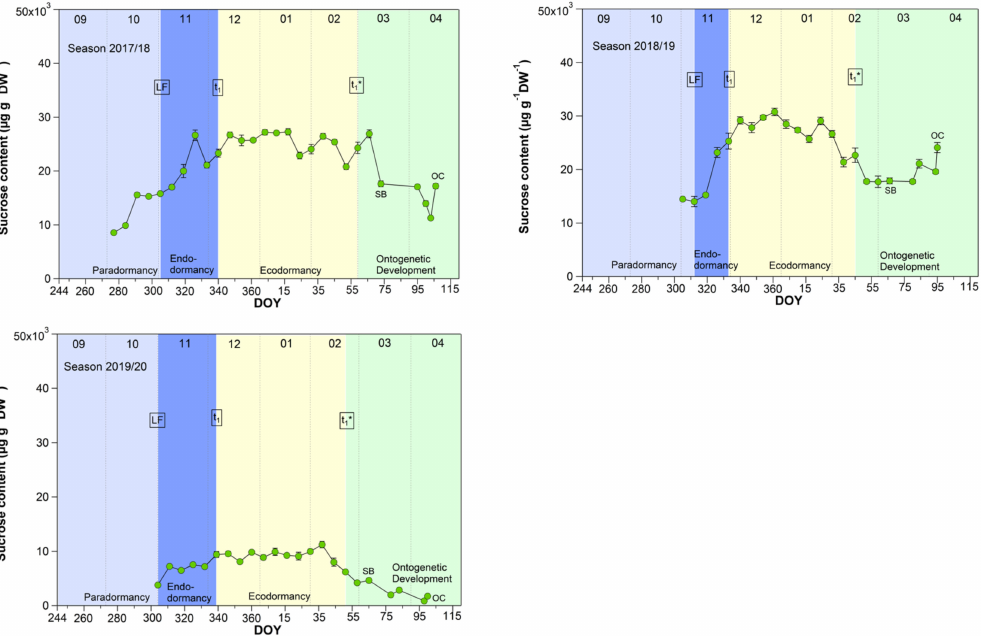
Figure 4. Sucrose in sweet cherry buds cv. Summit, 2011/12–2019/20. ‘Total leaf fall’ (LF), endodormancy release (t 1 ), beginning of ontogenetic development (t 1 *), ‘swollen bud’ (SB) and ‘open cluster’